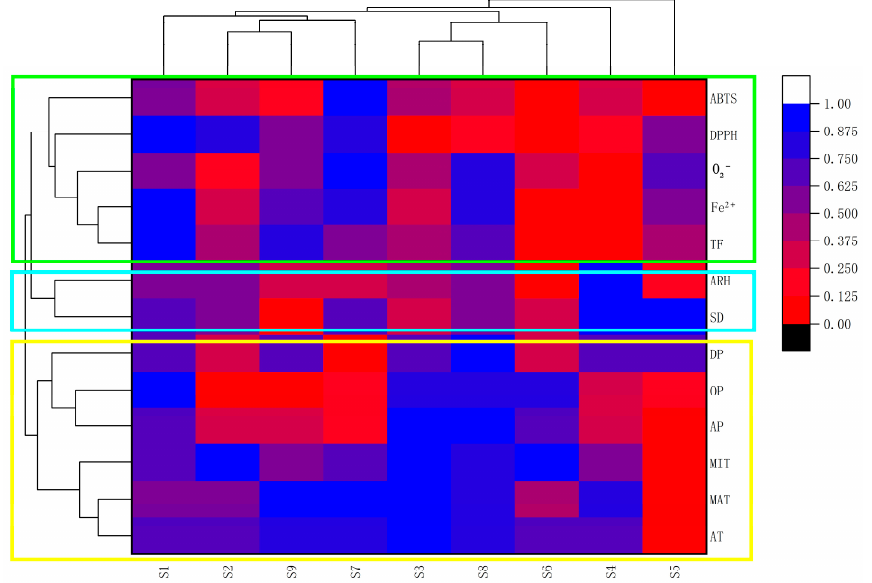
Figure 7. Dendrogram and heatmap of hierarchical cluster analysis of climate factors, TFC and antioxidant activity among nine main producing areas of W. japonica. Concentrations are illustrated by a color gradient from blue (high) to red (low).